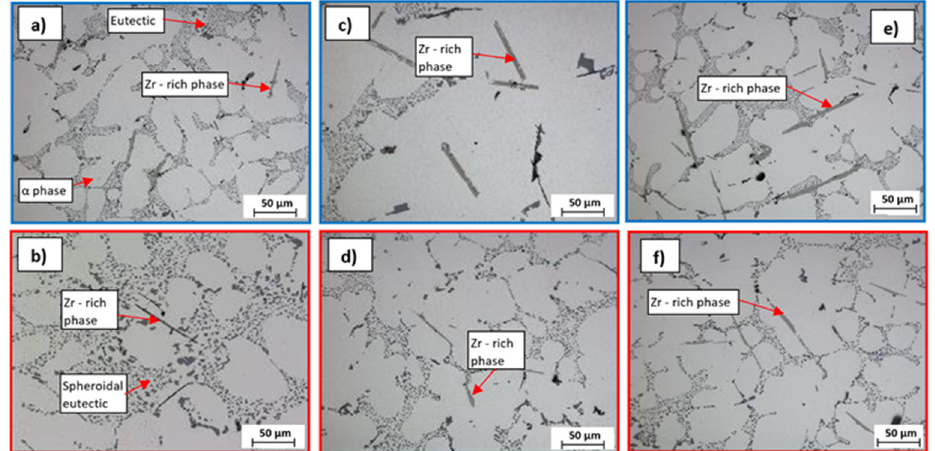
Figure 6. Microstructure of experimental alloys, H 2 SO 4 etch., ( a ) alloy E1 0.1 wt. % Ti in the cast state, ( b ) alloy E1 0.1 wt. % Ti after heat treatment, ( c ) alloy E2 0.2 wt. % Ti in the cast state, ( d ) alloy E2 0.2 wt. % Ti after heat treatment, ( e ) alloy E3 0.3 wt. % Ti in the cast state, and ( f ) alloy E3 0.3 wt. % Ti after heat treatment.